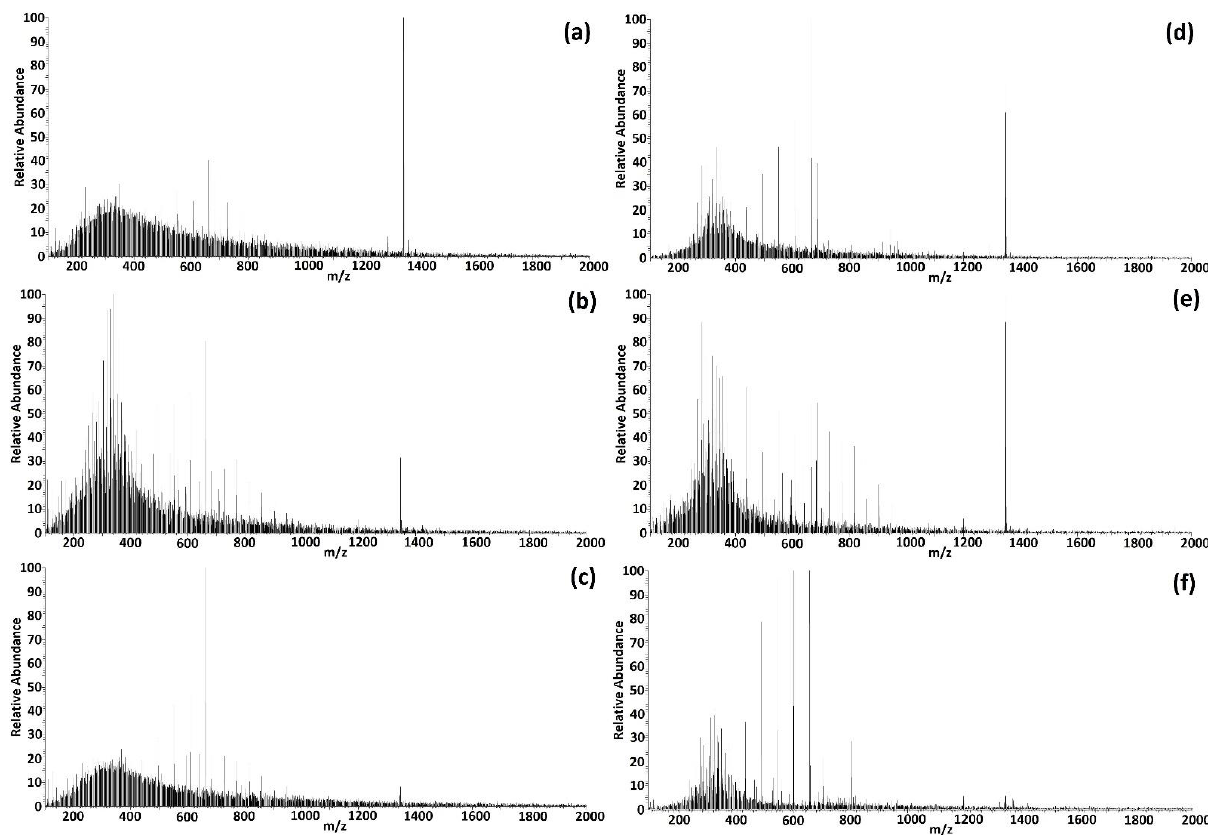
Figure 5. Positive-ion ESI-MS spectra of the products of liquid products of catalytic pyrolysis of BMP at ( a ) 500 °C, ( b ) 550 °C, ( c ) 600 °C, and CMP at ( d ) 500 °C, ( e ) 550 °C, and ( f ) 600 °C. at ( a ) 500 ◦ C, ( b ) 550 ◦ C, ( c ) 600 ◦ C, and CMP at ( d ) 500 ◦ C, ( e ) 550 ◦ C, and ( f ) 600 ◦